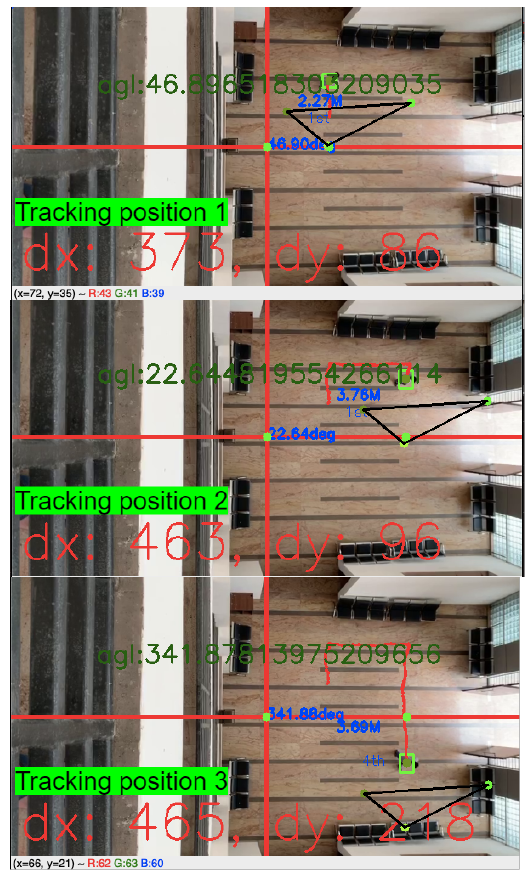
Figure 12. Tracking of moving object and position estimation (Positions 1, 2, and 3).